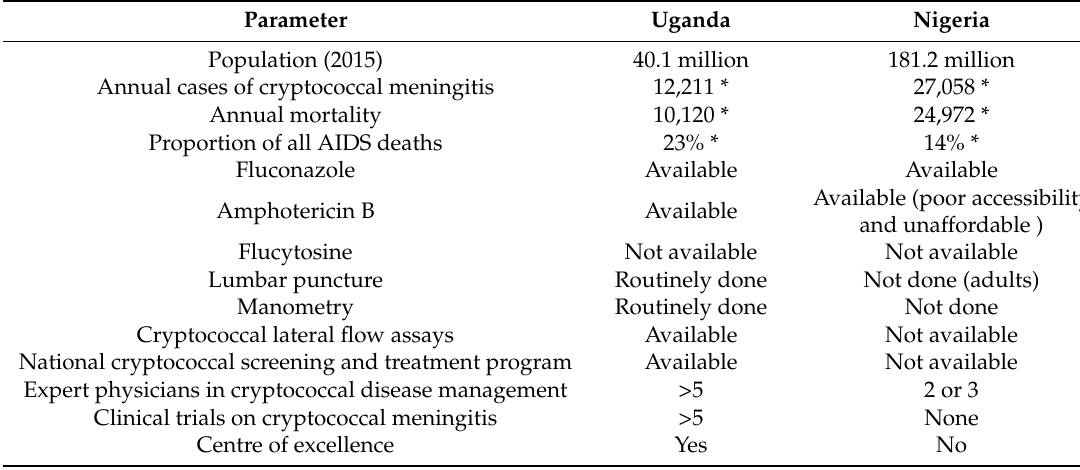
Table 1. Cryptococcal meningitis burden and availability of the essential management package in resource-limited settings. A comparison of Uganda and